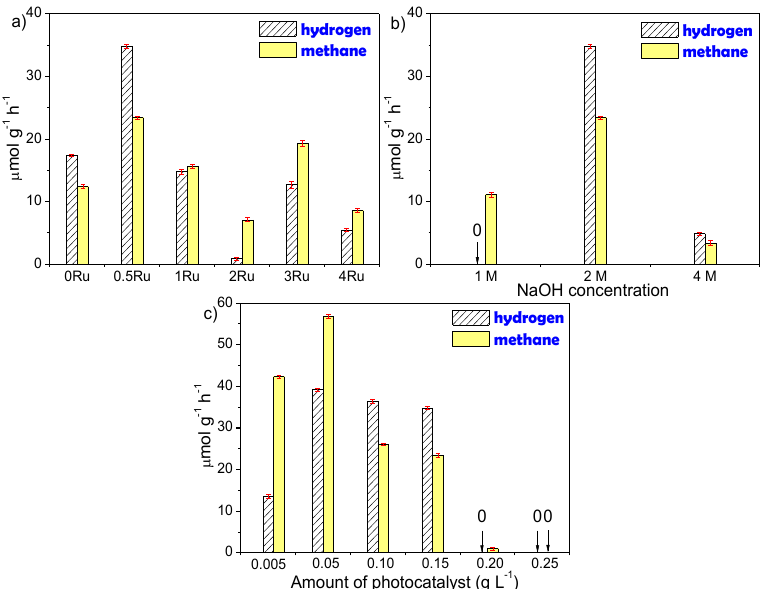
Figure 5. ( a ) Relation of the Ru doping amount to the photocatalytic carbon dioxide reduction (2 M NaOH, and 0.15 g L −1 photocatalyst dosage). ( b ) Relation of the concentration of reductant to the photocatalytic carbon dioxide reduction (0.15 g L −1 of 0.5 Ru and Cu co-doped ZnS nanopowders (RCZS)/MSG photocatalyst). ( c ) Relation of the content of 0.5RCZS/MSG photocatalyst to the photocatalytic carbon dioxide reduction (2 M NaOH).